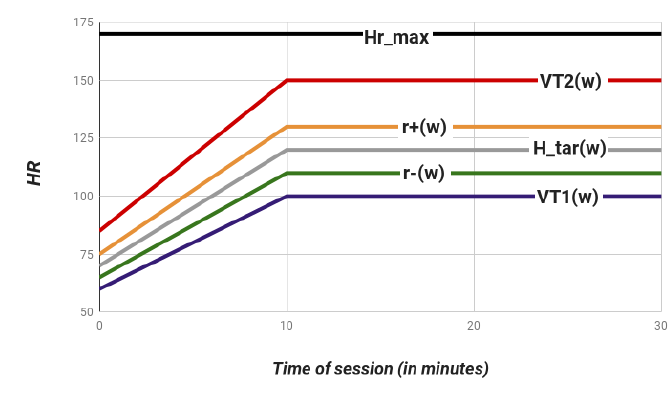
Figure 2. Evolution of the values of parameters from progressive to maintenance stages for a rehabilitation session: duration range (30 min), duration of progressive stage (10 m) , OHRTZ = [130 bpm, 110 bpm], HR max = 170 bpm, and VT r ∗ + , − the basal ranges [ r 0 + , r 0 − ] = [65 bpm, 75 bpm], and the lower and upper basal threshold VT 0 [60 bpm, 85 bpm] for the patient. HR: heart rate; bpm: number of contractions of the heart per